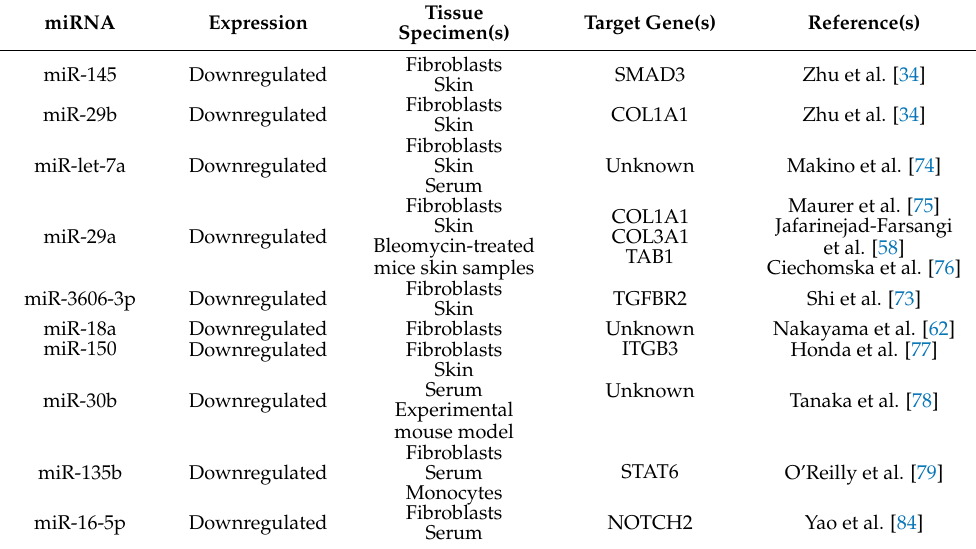
Table 2 outlines the main characteristics of the antifibrotic miRNAs identified in patients with SSc. Table 2. Antifibrotic miRNAs involved in SSc